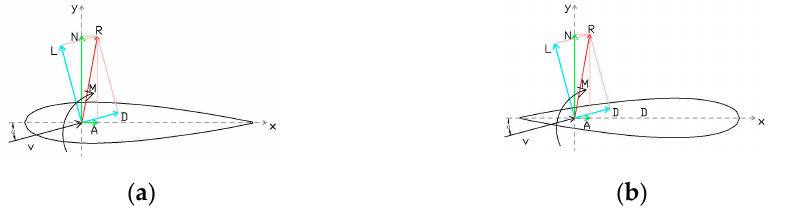
Figure 8. Definition of lift coefficient and moment coefficient in positive and negative directions. ( a ) Forward-blowing, ( b ) reverse blowing.